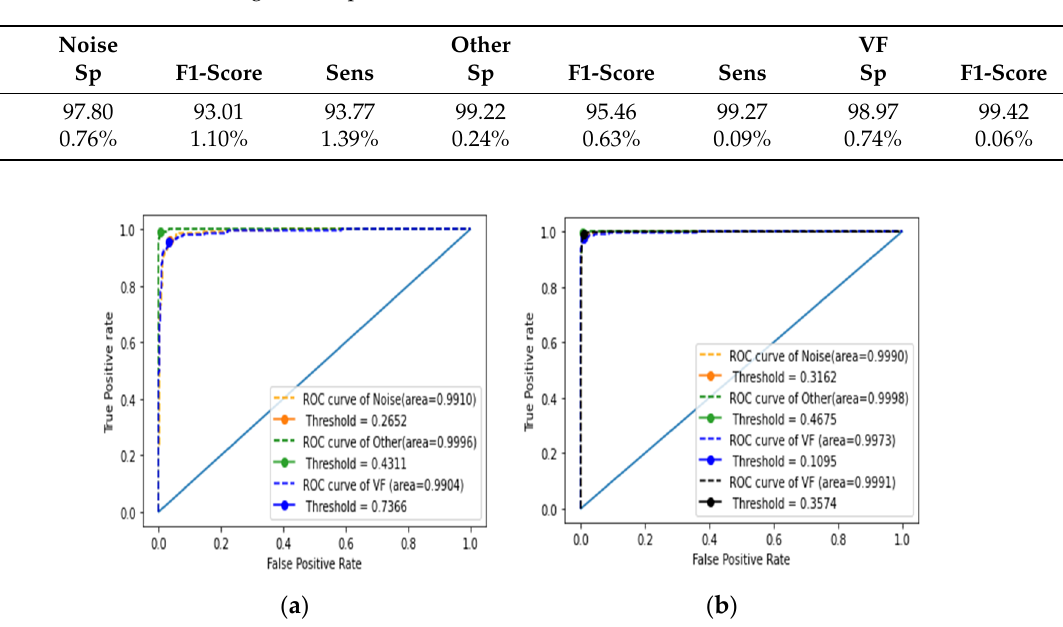
Table 7. First stage performance measure for the cross-validation (5-fold) using training validation and testing accuracies.